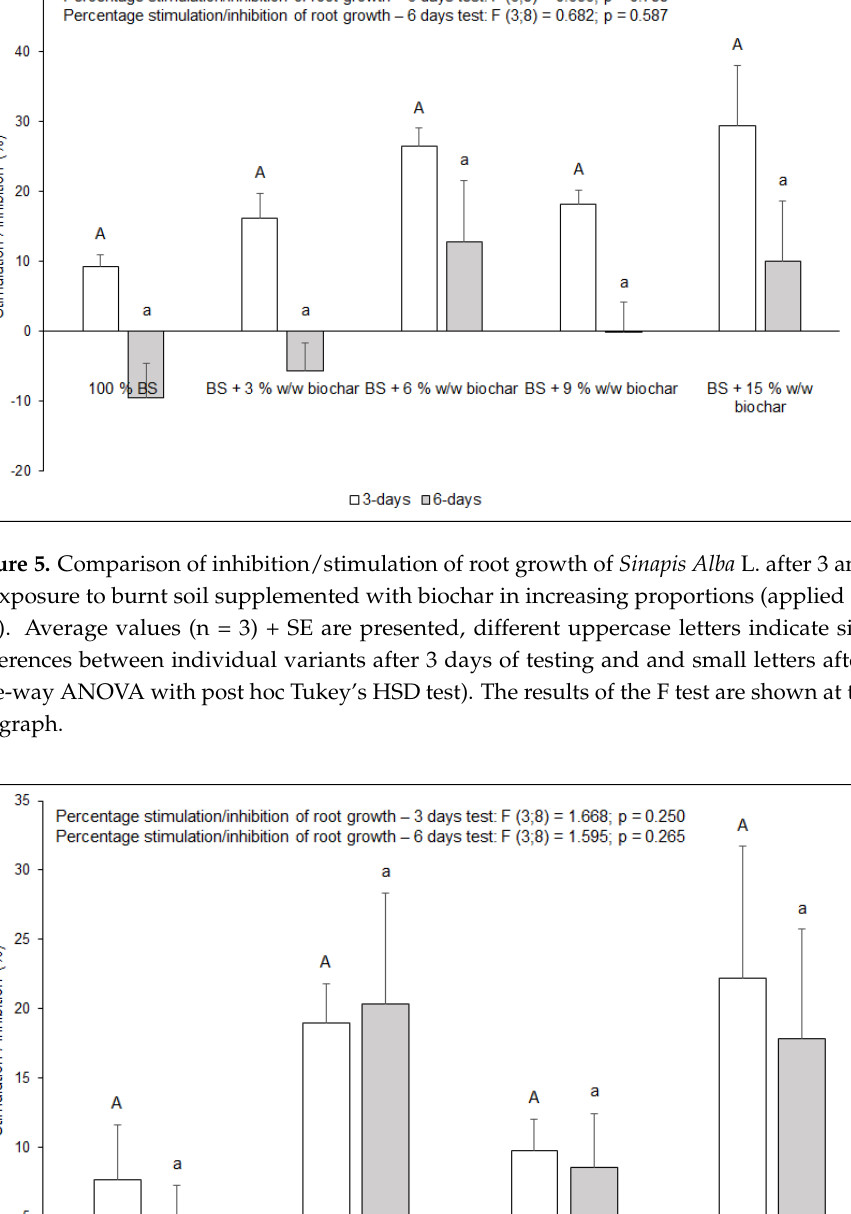
changes in the phytotoxicity in the treatments with increased proportion of biochar (6%